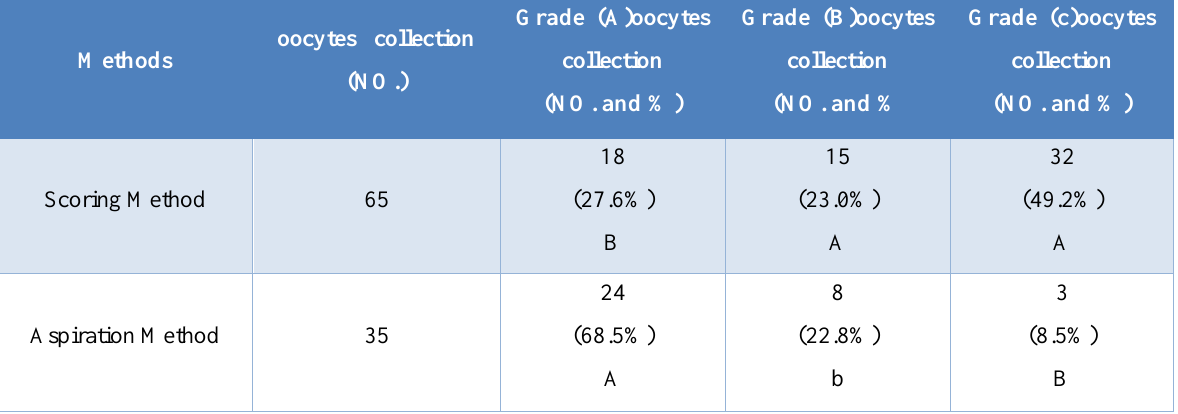
Table, 2: Effect of the harvest recovery methods on the quality of oocytes collected from buffalo.